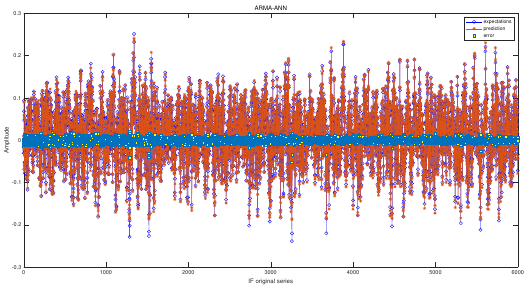
Figure 10. Prediction result of ARMA-ANN model for IF original time series.